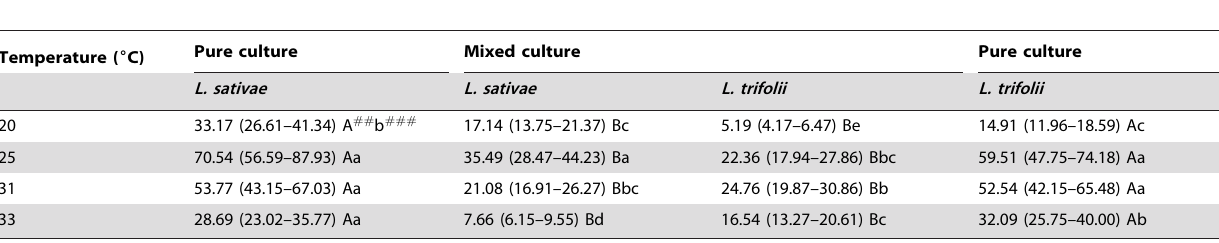
Table 4. Net reproductive rates ( R 0 ) for Liriomyza sativae and L. trifolii in pure and mixed cultures maintained at four different temperatures #